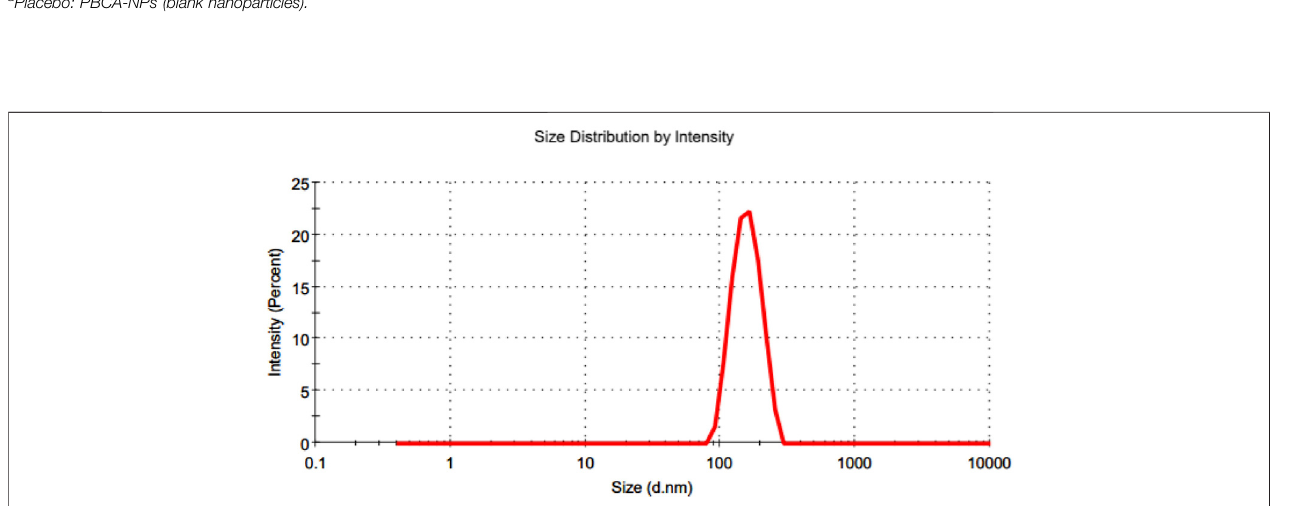
Frontiers in Nanotechnology |